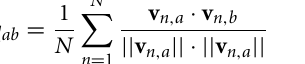
Frontiers in Neural